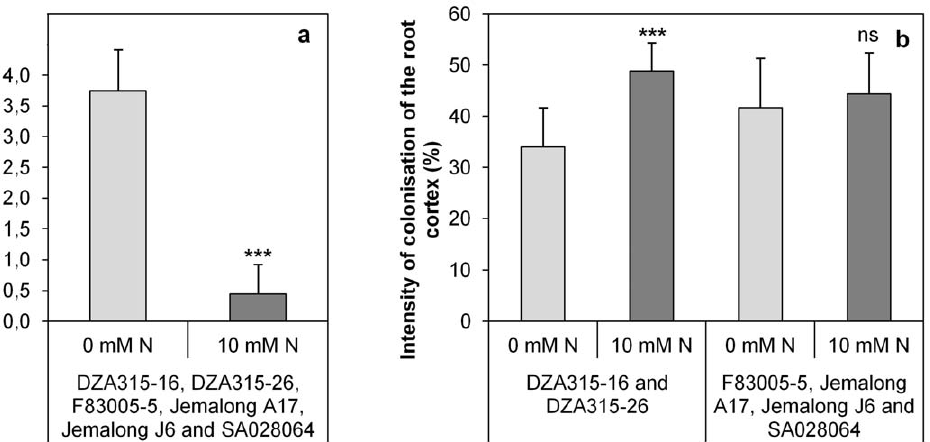
Figure 2. Contrasted symbiotic microbial infection among different Medicagotruncatula genotypes and soil N availability. a. Intensity of nodulation of the six Medicago truncatula genotypes studied under contrasted soil N availability (0 mM and 10 mM N). The intensity of nodulation was evaluated using a visual scale [25] which includes five scores: 0 (absence of nodules), 1 (only some white small size nodules), 2 (both white and pink small size nodules), 3 (mainly pink larger size nodules), and 4 (many pink large size nodules). b. Intensity of colonisation of the root cortex (M%) under contrasted soil N availability (0 mM and 10 mM N) for the group of genotype DZA315-16/DZA315-26 and the other genotypes.